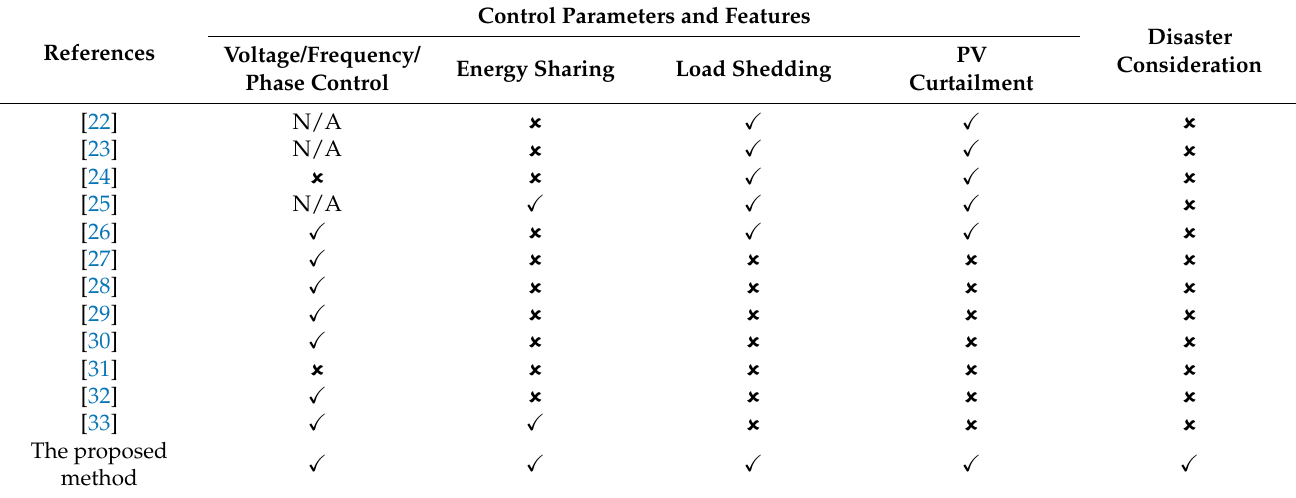
Table 2. Summary of Related Works: Control Parameters and Features.